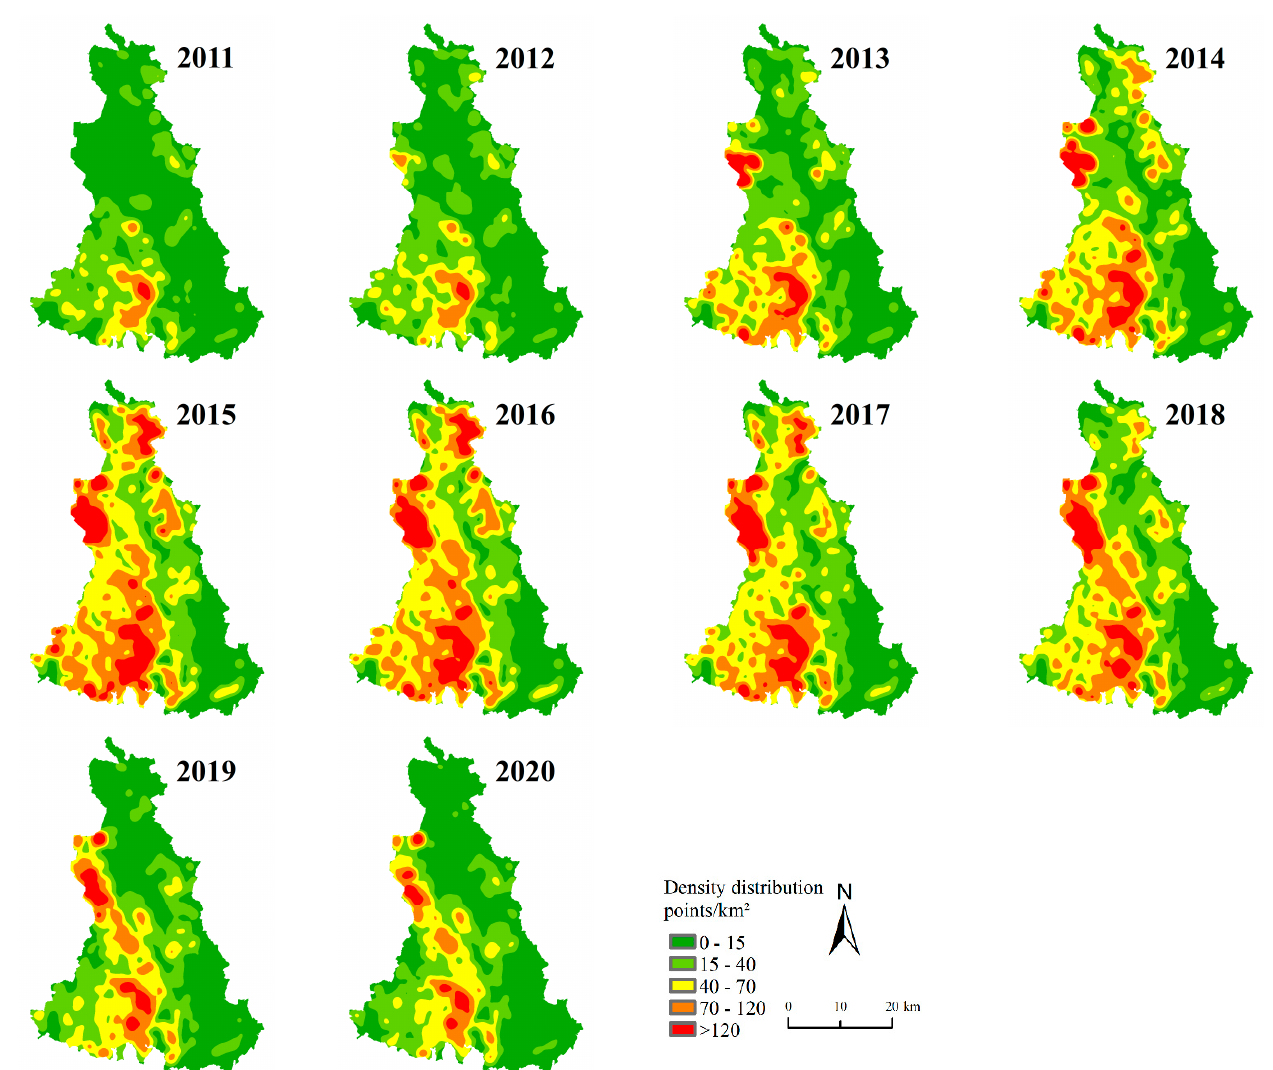
Figure 8. Spatial distribution of kernel density for abandoned cropland in Gaolan County from 2011 to 2020.